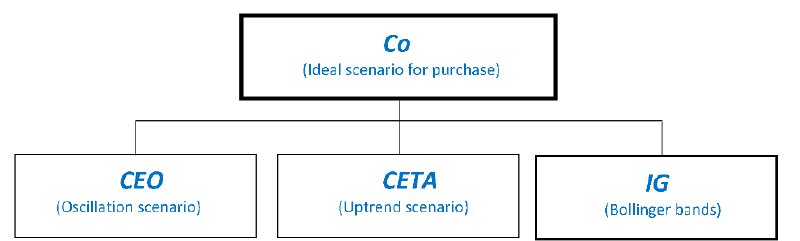
Figure 1. Evaluation of “the asset is ‘good to be bought’”. In the proposed approach, the truth degree of the “good oscillation conditions” sce- nario at moment t is a thesis defined as “if there is oscillation at time t then the conjunction of four assertions is true”. Thus, “it is true that there are good oscillation conditions at time t if and only if it is true that the rule associated with moving averages indicate so and it is true that the set of rules associated with stochastic oscillators indicate so and it is true that the set of rules associated with the moving averages of convergence/divergence indicate so and it is true that it is true that there is a situation of a break out”. Let O ( t ) denote that time t belongs to an oscillation scenario, that CMM ( t ), EST ( t ), MACD ( t ), and CB ( t ) denote